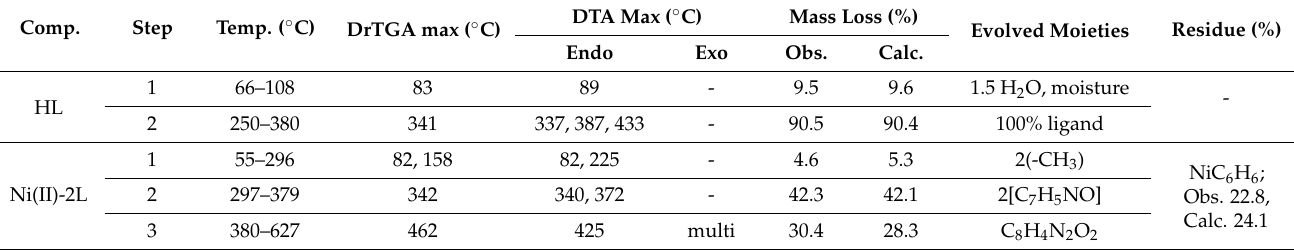
Figure 7. Schematic presentation of suggested thermogravimetric analysis fragmentation pattern, including the predicted mass-loss percentage. Table 5. Thermogravimetric analysis (TGA), derivative (Dr)-TGA, and differential thermal analysis (DTA) data of the N (cid:48) -(4-methoxybenzylidene)benzohydrazide (HL) Schiff base and Ni(II)-2L.